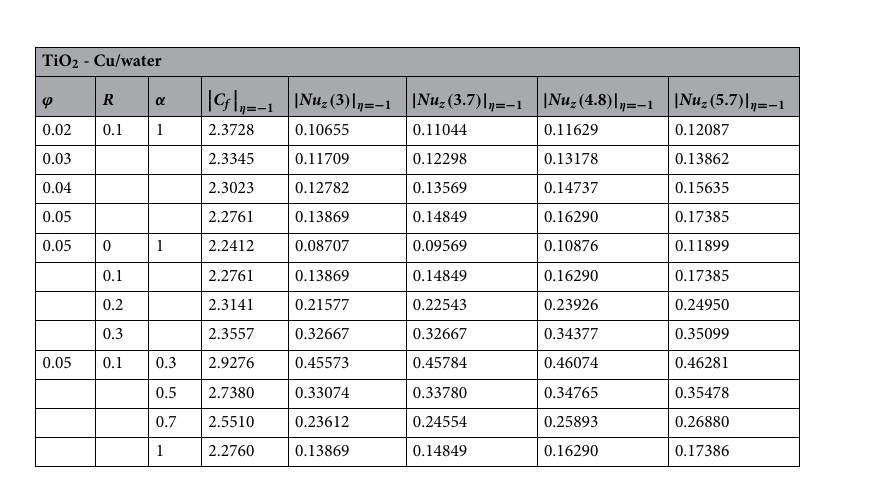
Table 4. Numerical variation in shear stress against ϕ = ϕ 1 = ϕ 2 , R , α( TiO 2 − Cu/water) ( HN fd